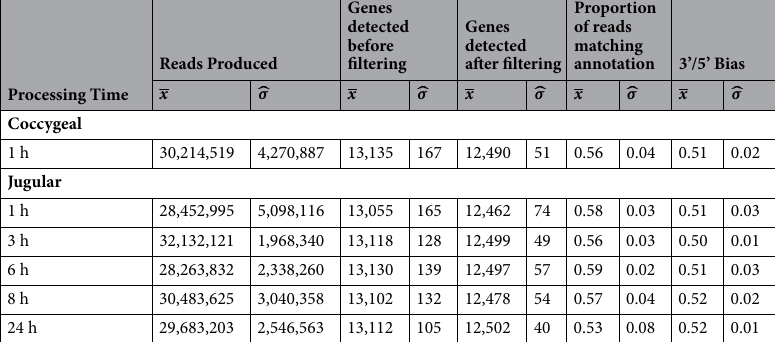
Table 2. Metrics for RNA-sequencing data produced from peripheral white blood cells.